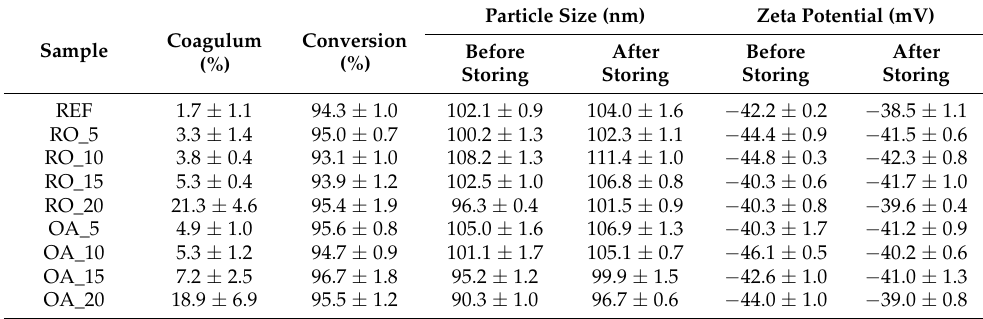
Table 4. Properties of latexes and results of their storage stability testing (storing at 40 ◦ C for 60 days).